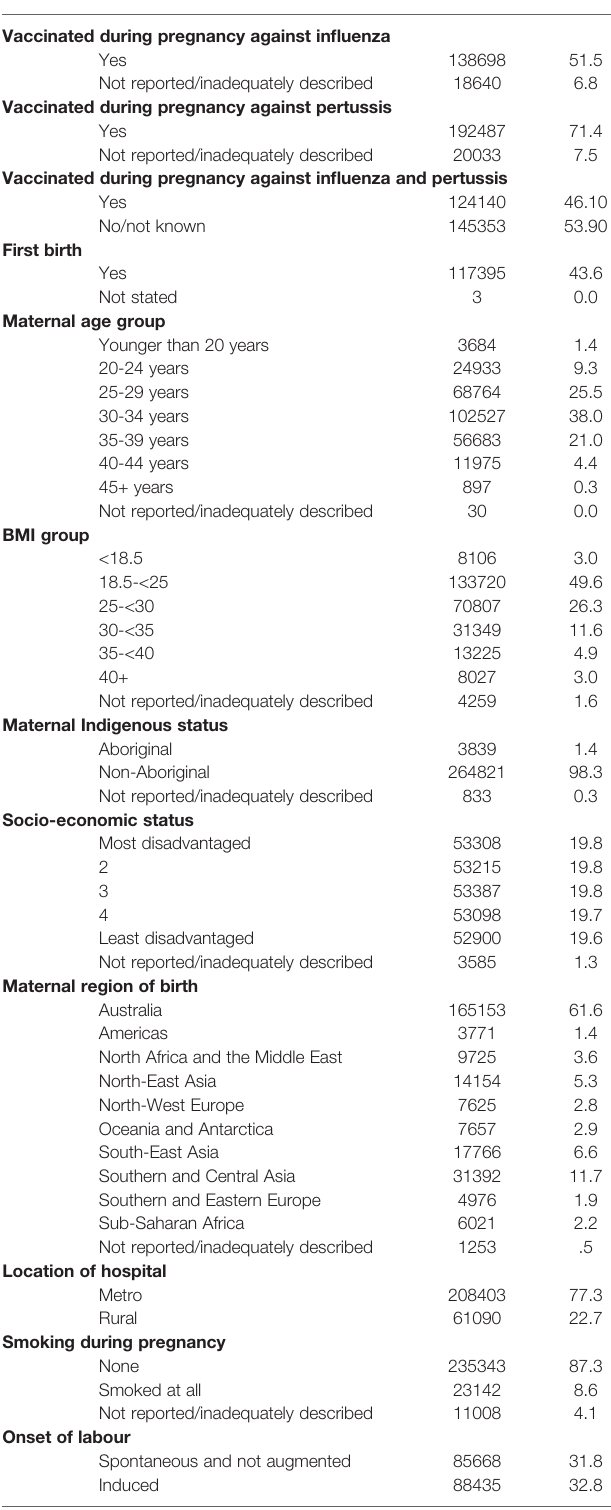
TABLE 1 | Maternal characteristics (includes those with missing vaccination status; excludes <28w and